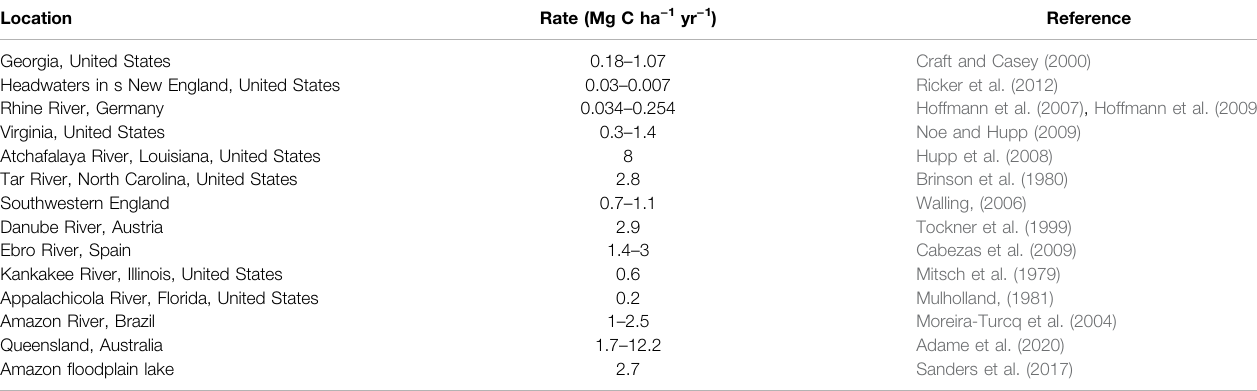
TABLE 2 | Published values for soil organic carbon accumulation rates on fl oodplains (after Sut fi n et al., 2016; Table 3 ).